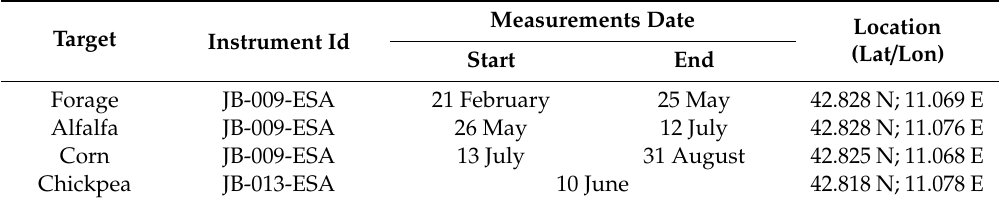
Table 1. Field spectroscopy measurements collected on di ff erent crops. The crop species, FLOX serial number, start / end dates of measurements for di ff erent targets and latitude / longitude of the di ff erent point measured are indicated.